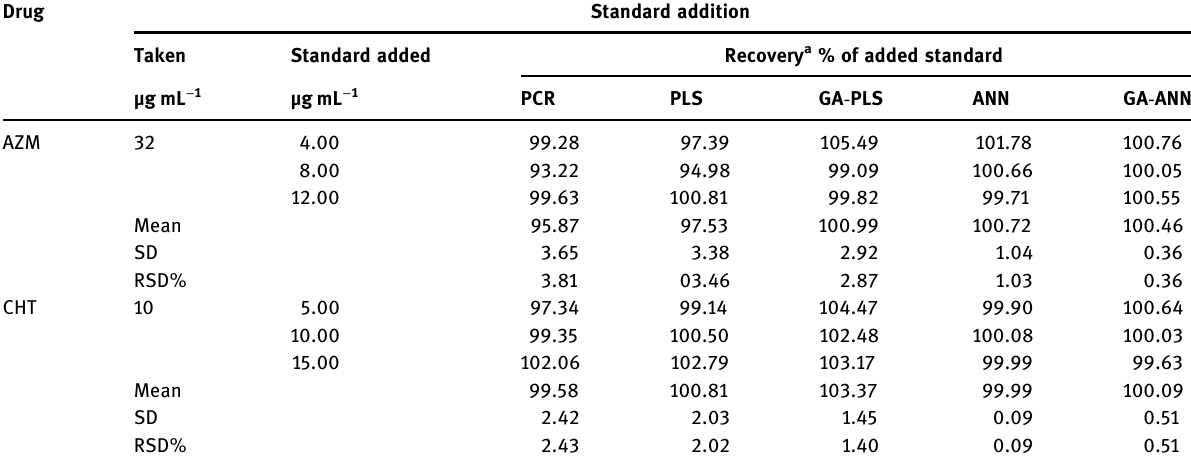
Table 6: Application of standard addition technique for determination of AZM and CHT in Edarbyclor ® tablets ( Batch No. 459512 ) by the proposed chemometric